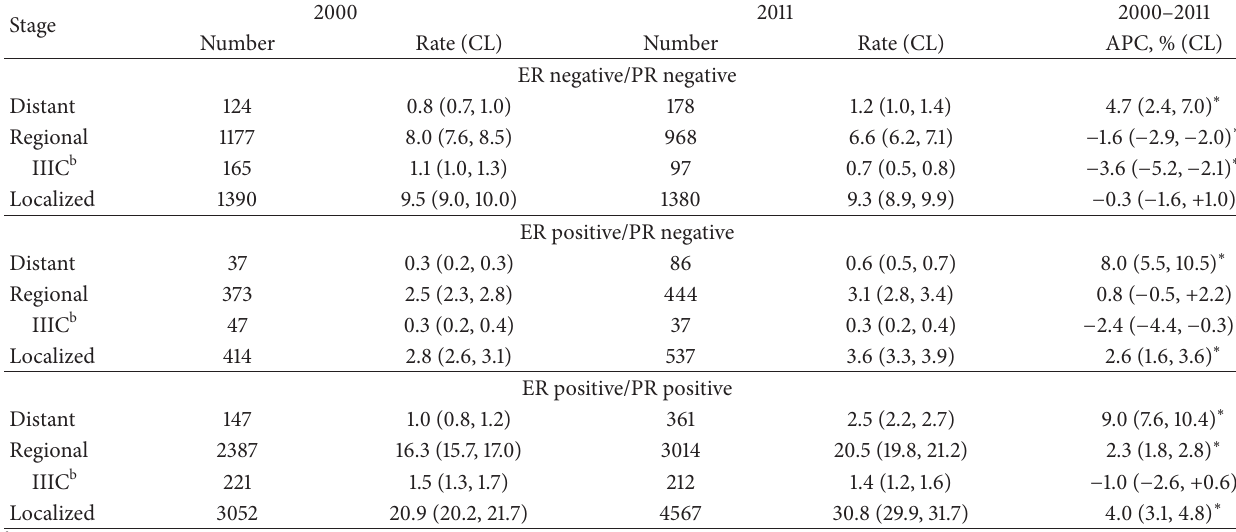
Table 2: Trend in age-standardized incidence rate for women aged 25–49 years with invasive breast cancer in SEER registries, by estrogen (ER) and progesterone (PR) hormone-receptor status category: annual percent change (APC) by stage at diagnosis a,b .